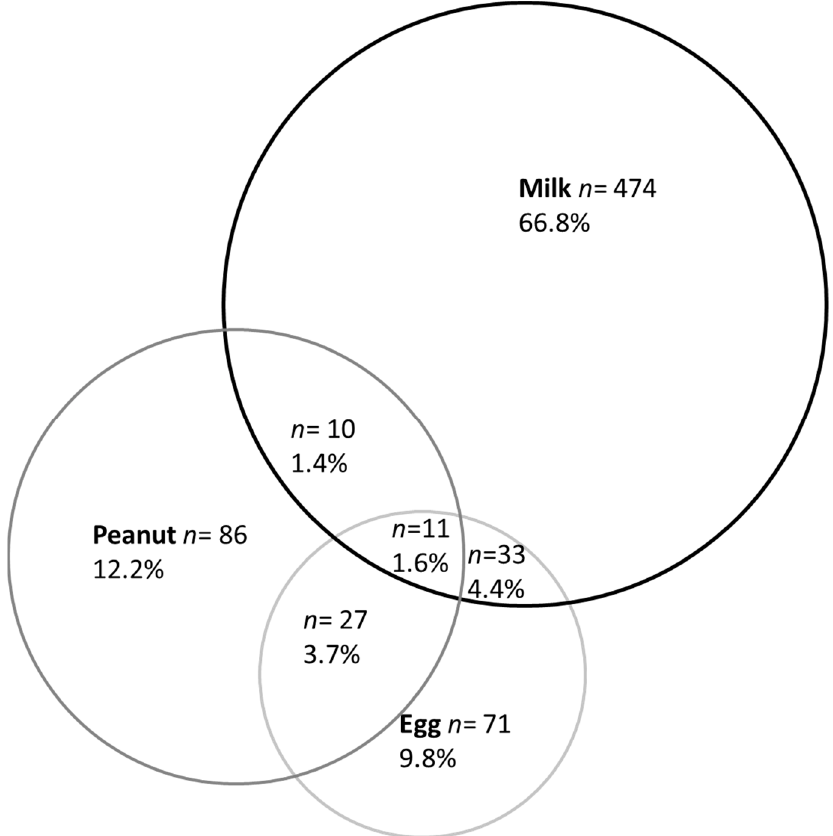
Figure 2. Venn diagram depicting the overlap of milk, egg and peanut allergies in children with food allergies up to 5.5 years of age. n : number.